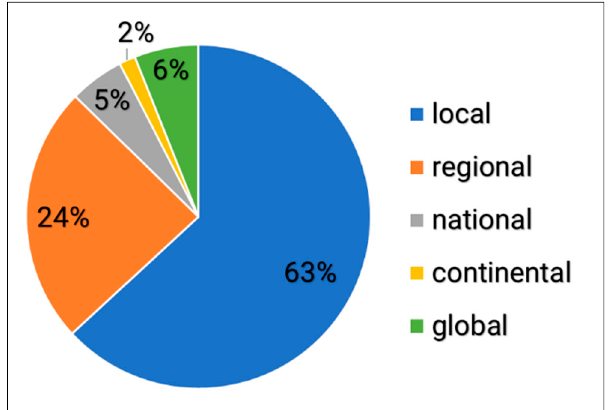
Figure 4. Proportion of savanna spatio-temporal mixed pixel analysis publications according to the spatial extend of the study area.